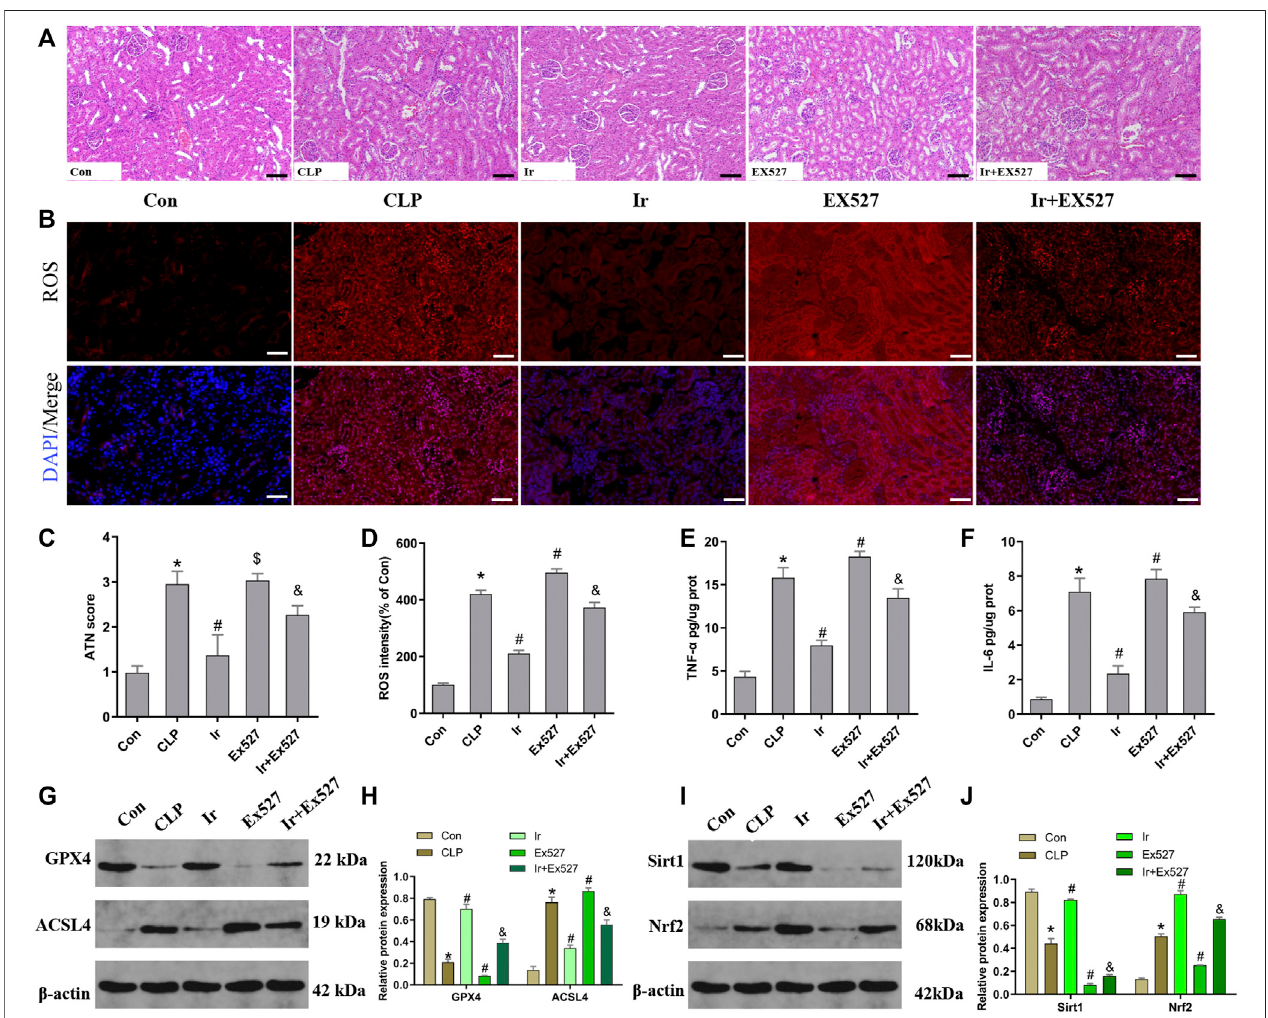
FIGURE 6 | Irisin attenuates CLP-induced kidney injury through the SIRT1/Nrf-2 pathway. Mice were given a sham operation or CLP model operation, with or without irisin (Ir) and Ex527 administration. (A) Representative images (200×) showing HE staining of renal sections (scale bar = 50 μ m). (B) Representative fl uorescent imagesofDHEStaining(scalebar=50 μ m). (C) Acutetubularnecrosisscore(ATNscore). (D) Thequanti fi cationofDHE fl uorescenceintensity.ThelevelofTNF- α (E) and IL-6 (F) in the kidney tissue. (G) Western blot analysis of GPX4 and ACSL4 proteins in the kidney tissue. ( n = 6). (H) Quantitation of results in (G) . (I) Western blot analysis of SIRT1 and Nrf2 proteins in the kidney tissue. (J) Quantitation of results in (I) . * p < 0.05 vs. Con group, # p < 0.05 vs. CLP group, & p < 0.05 vs. CLP + Ir group, $ p > 0.05 vs CLP group. Data are presented as mean ± SD ( n = 6).